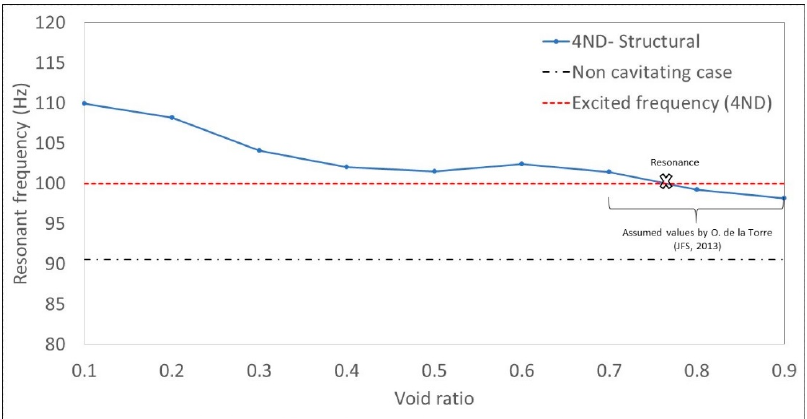
Figure 8. Risk of resonance for the 4ND-mode with cavitation effects.